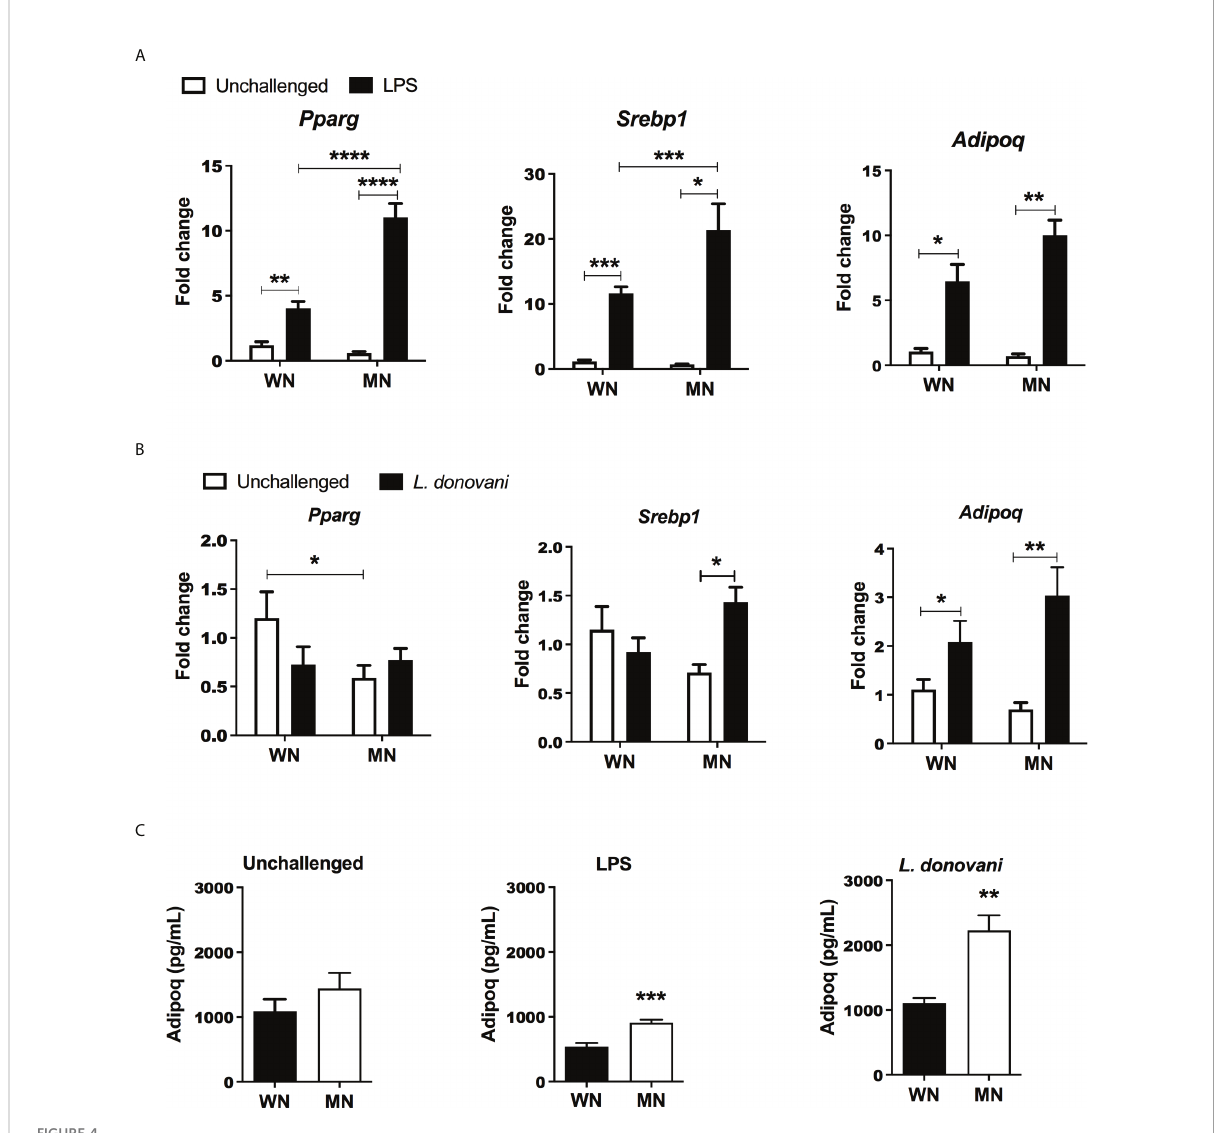
FIGURE 4 Malnutrition promotes expression of genes associated with adipogenesis following in fl ammatory challenge. (A) Expression of genes associated with adipocyte differentiation [Peroxisome Proliferator Activated Receptor gamma ( Pparg ), Sterol regulatory element binding transcription factor 1 ( Srebp1 ), and Adiponectin ( Adipoq )] in the bone marrow of naïve well-nourished (WN) and malnourished (MN) mice challenged with LPS and evaluated at 24h post-challenge. Data are shown as the mean fold change expression compared to naïve unchallenged (Un) mice. (B) Gene expression associated with adipocyte differentiation ( Pparg , Srebp1, Adipoq ) in the bone marrow of well-nourished (WN) and malnourished (MN) mice challenged with L. donovani and evaluated at 72h post-challenge. Determined by RT-qPCR. (C) Adiponectin protein levels in bone marrow lysates of well-nourished (WN) and malnourished (MN) mice (n=4 mice per group) unchallenged (UN) or challenged with LPS or L. donovani ( Ld ). LPS-challenged mice were evaluated at 24h post-challenge and L. donovani -challenged mice were evaluated at 72h post-challenge. Determined by Luminex and expressed as the mean concentration (pg/mL). N=5 mice per group, 2 experiments. **p<0.05, **p<0.01, ***p<0.001,